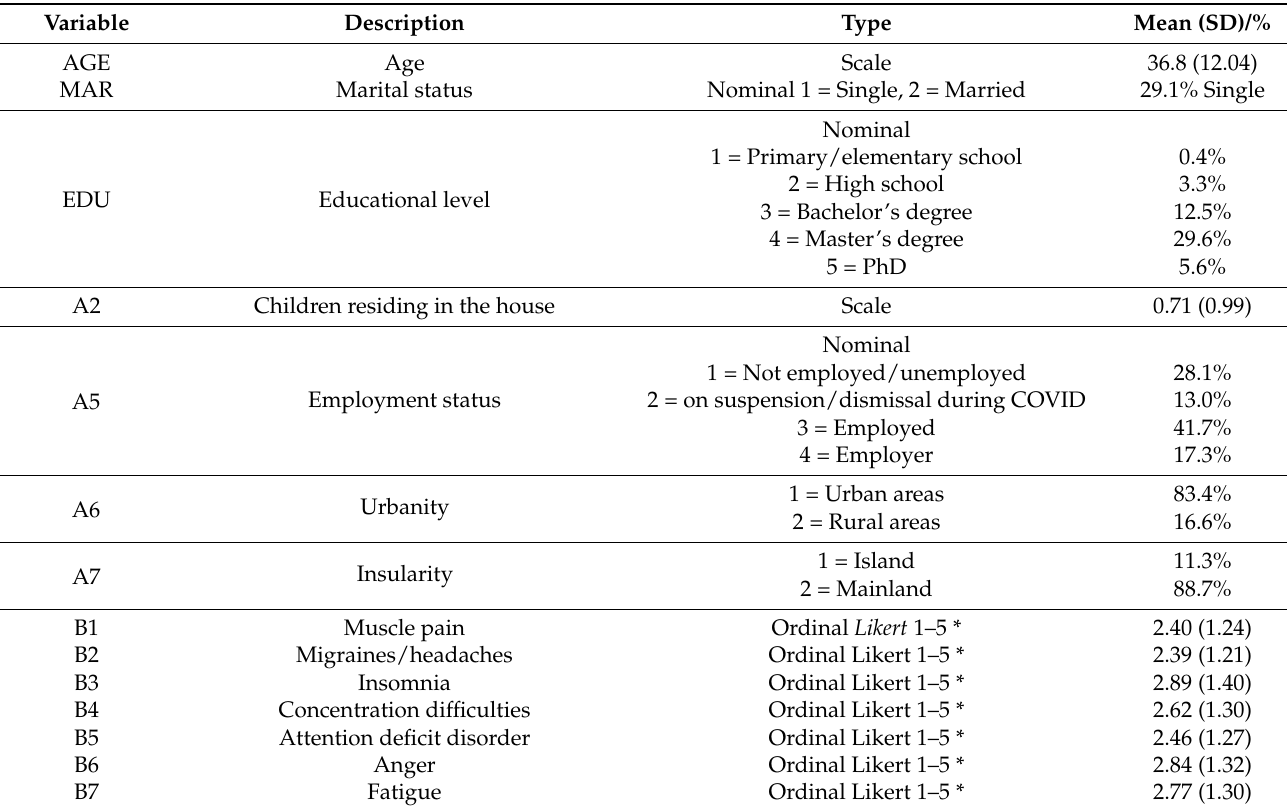
Table 2. Variables involved in the